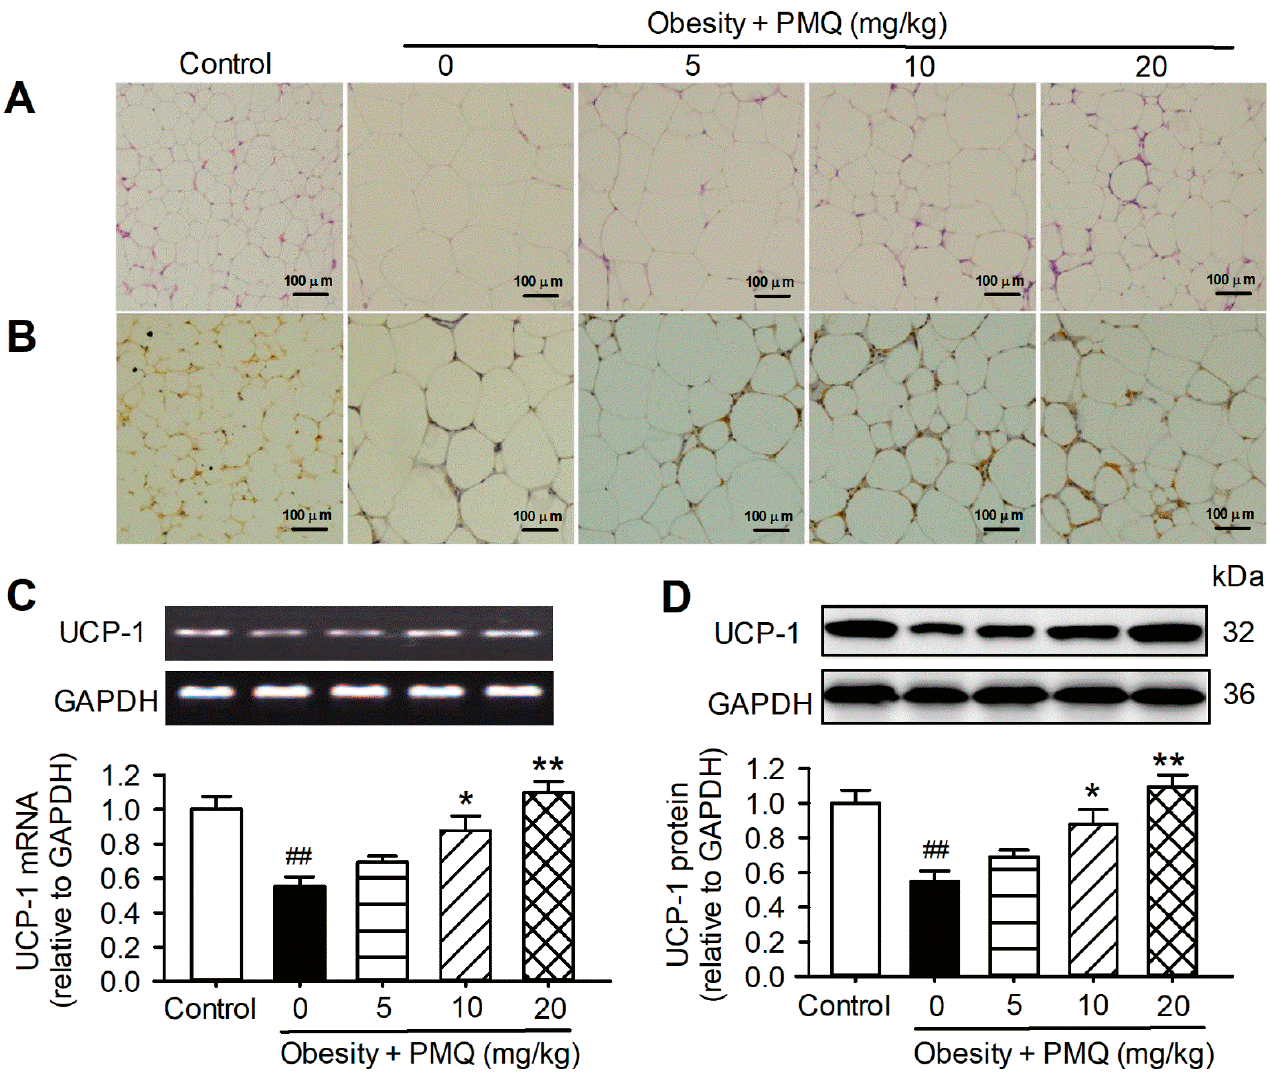
Figure 3. PMQ promotes the browning of inguinal WAT in MSG mice. ( A ) Representative images of H&E-stained paraffin sections of inguinal fat in the groups indicated (×100). ( B ) Representative images from UCP-1 immunohistochemistry on sections of inguinal fat (×100). ( C ) Relative mRNA levels of UCP-1 in inguinal WAT. ( D ) UCP-1 protein levels in inguinal WAT. ## p < 0.01 vs control group; * p < 0.05, ** p < 0.01 vs obesity group. Data are expressed as means ± SEM, n = 4.